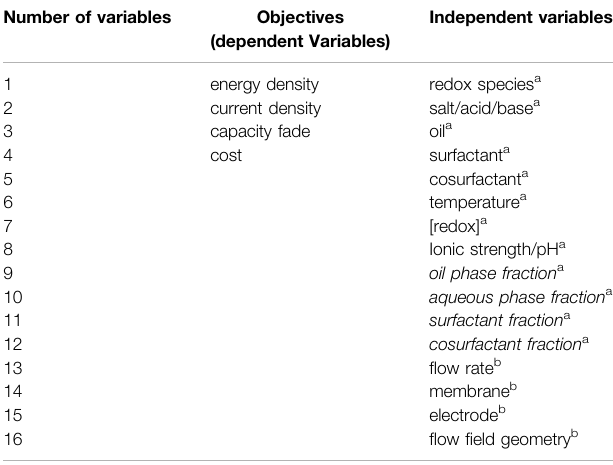
TABLE 4 | Optimization objectives and independent